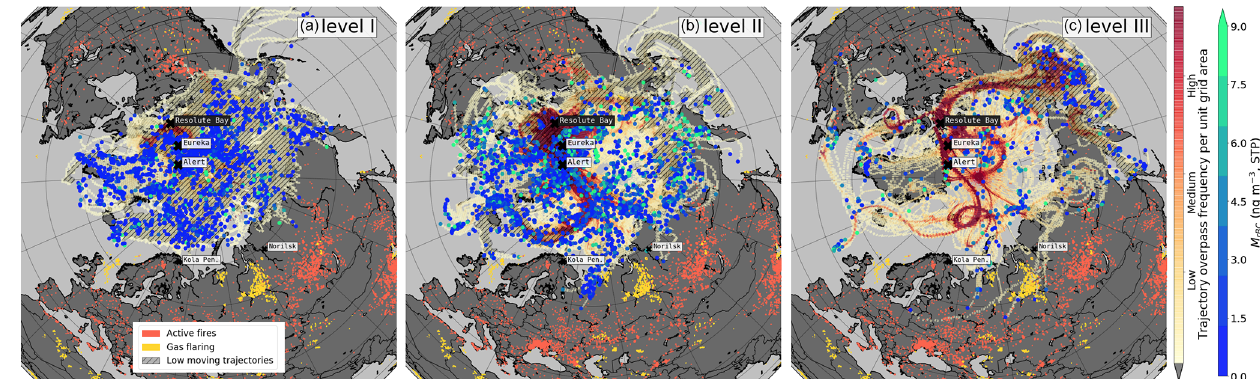
Figure 8. Heat maps of normalised back-trajectory overpass frequencies in each 0 . 5 ◦ × 0 . 5 ◦ grid cell for the flights of the summer campaign initialised from three potential temperature levels of the polar dome. Hatching shows areas in which trajectories were at atmospheric pressure > 920hPa. Dots at the end point of every trajectory, 10 days back in time, are colour coded with M rBC measured during the flights. The aircraft operated near Resolute Bay, which is marked with a black label. The map further shows MODIS active fire detections for the period 10 days prior to the first flight until the day of the last flight (orange dots) and known gas flaring sites (yellow dots) from the ECLIPSE emission